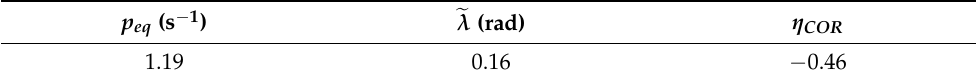
Table 5. Church. Equivalent rocking parameters calculated by the GhPython script.